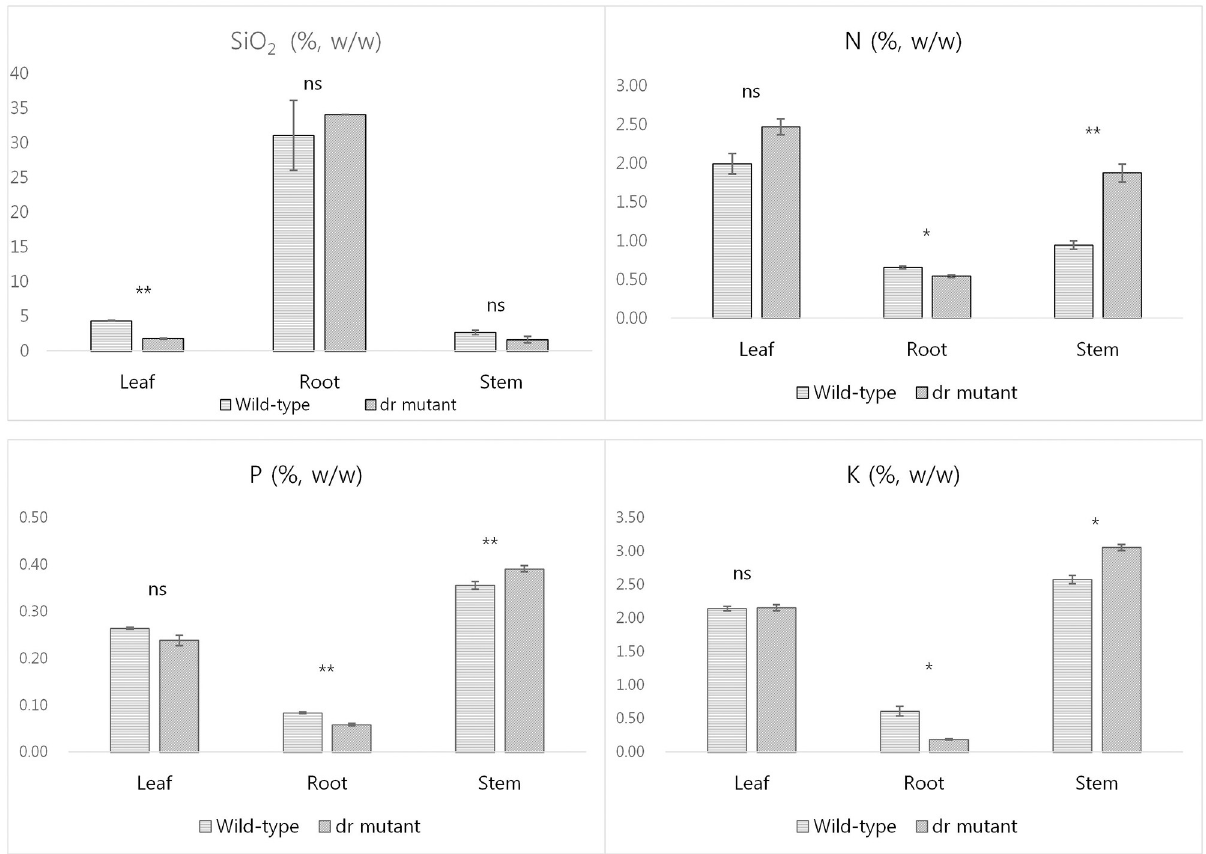
Fig 2. SiO 2 , N, P, and K content analysis in the wild-type and the dr mutant. Asterisks indicate the significance of differences between the wild-type and the dr mutant as determined by F-test ( � , P < 0.05; �� , p < 0.01; ns, not significant).